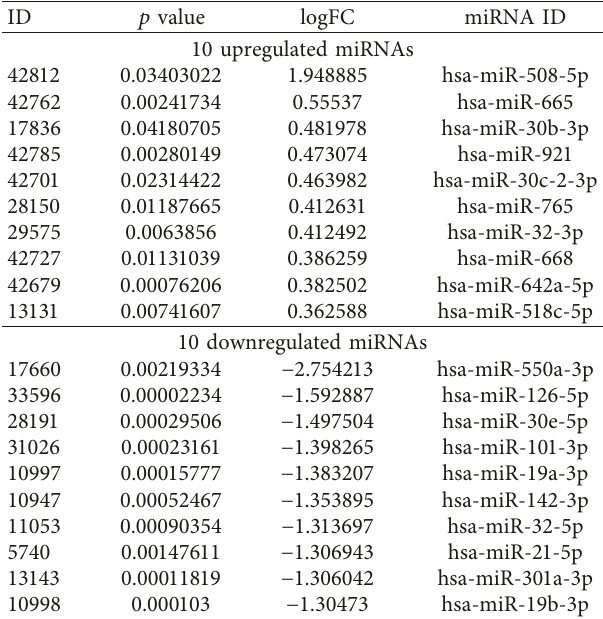
Table 1: 10 upregulated miRNAs and 10 downregulated miRNAs were screened in GSE16658